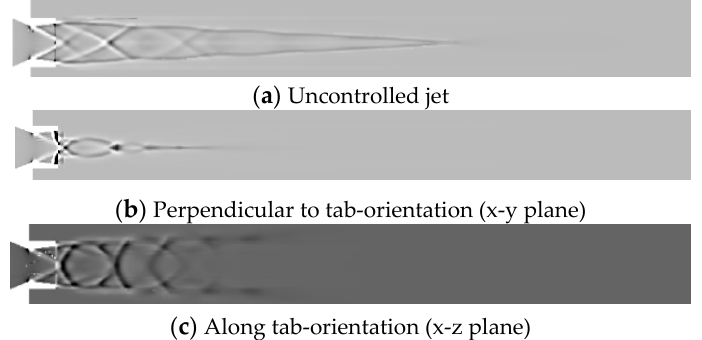
Figure 32. Schlieren views of uncontrolled and controlled jets at NPR 7 (underexpansion).